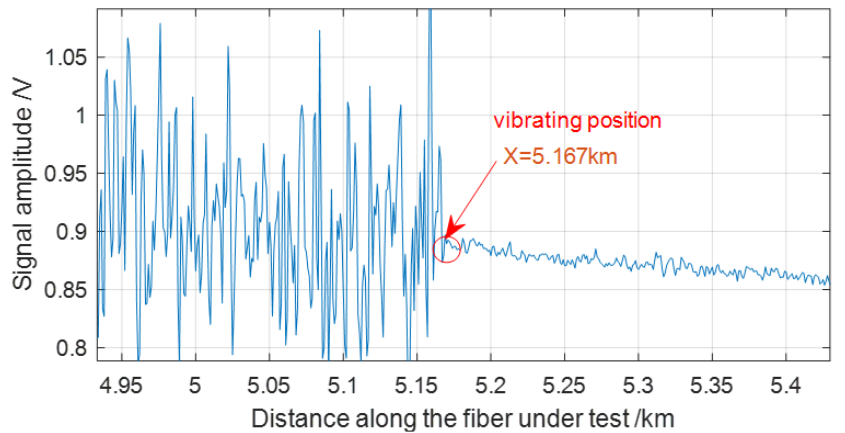
Figure 4. Contrast between the trace fluctuation before and behind the vibration